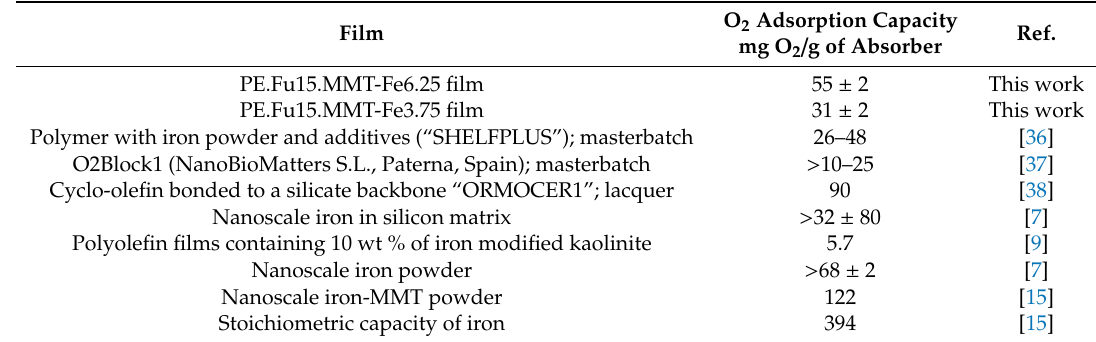
Table 4. Comparison with results reported in the literature.